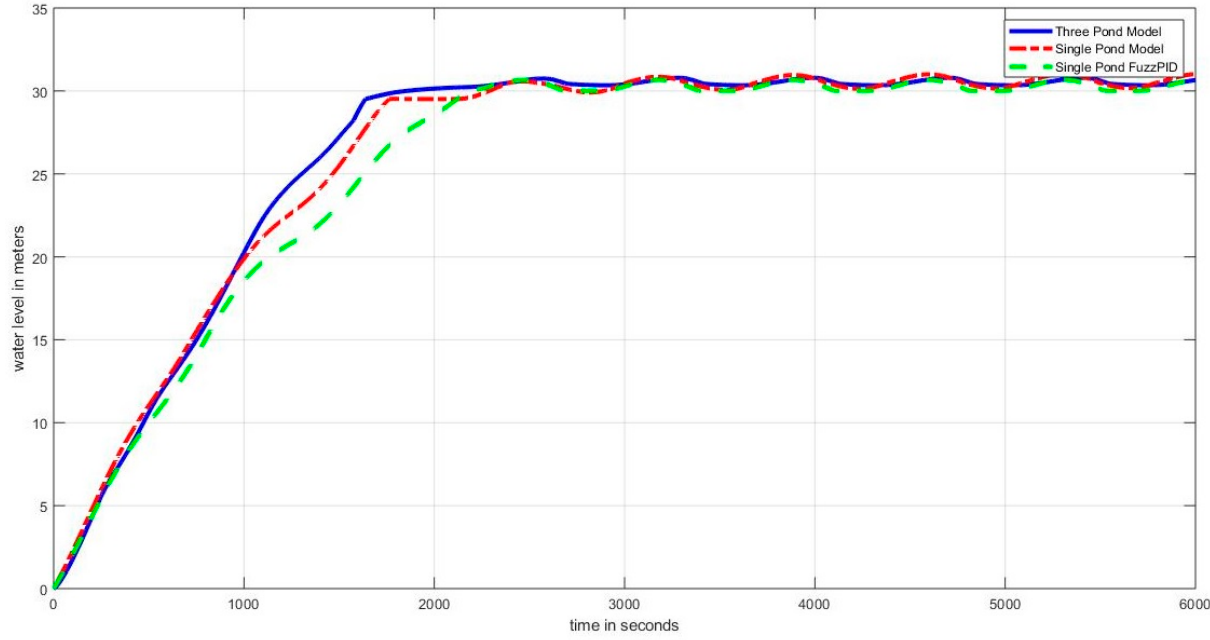
Figure 13. Traditional system (Fuzzy and FuzzyPID) and the proposed system (sinusoidal dis- turbance).